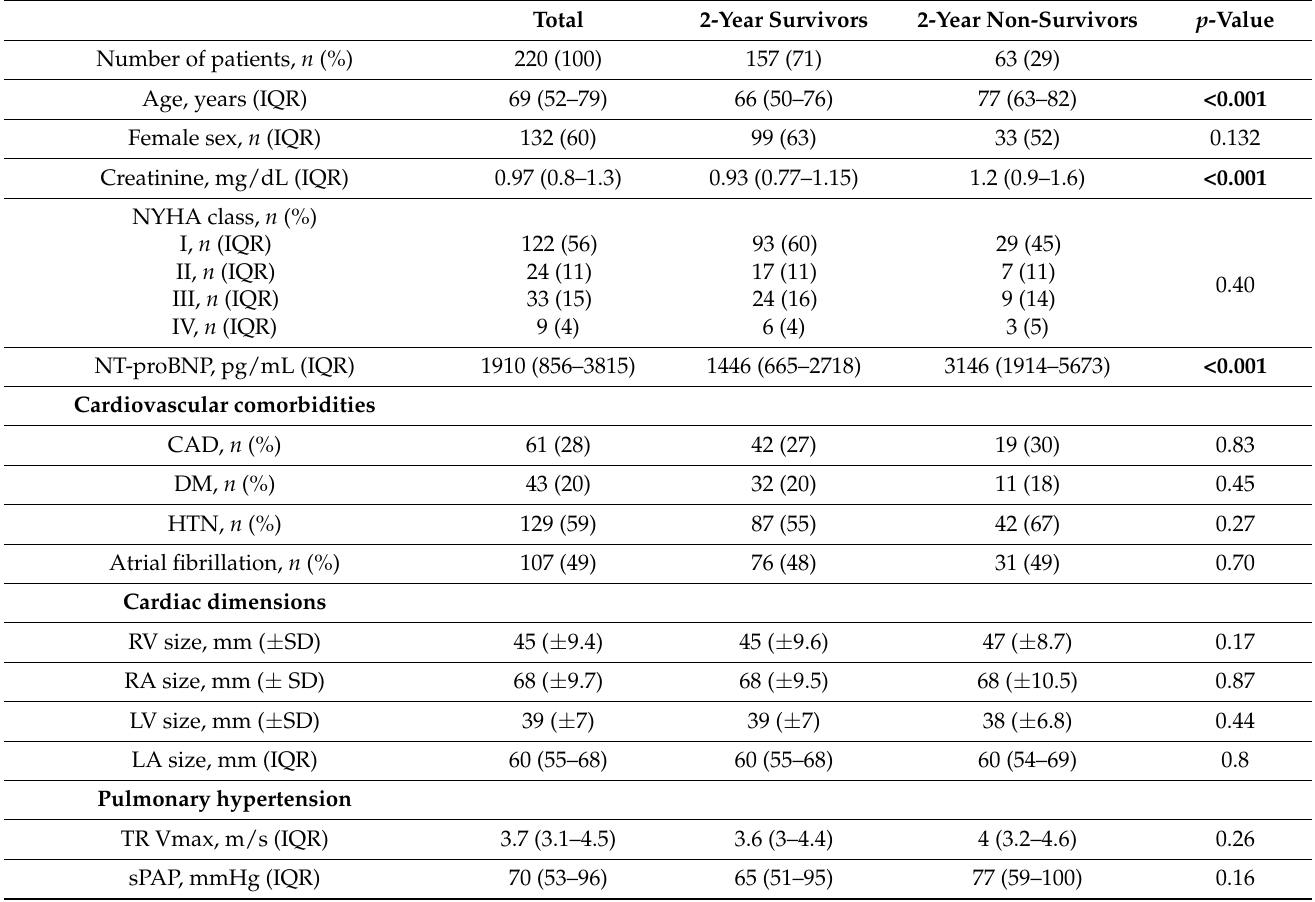
Table 1. Baseline